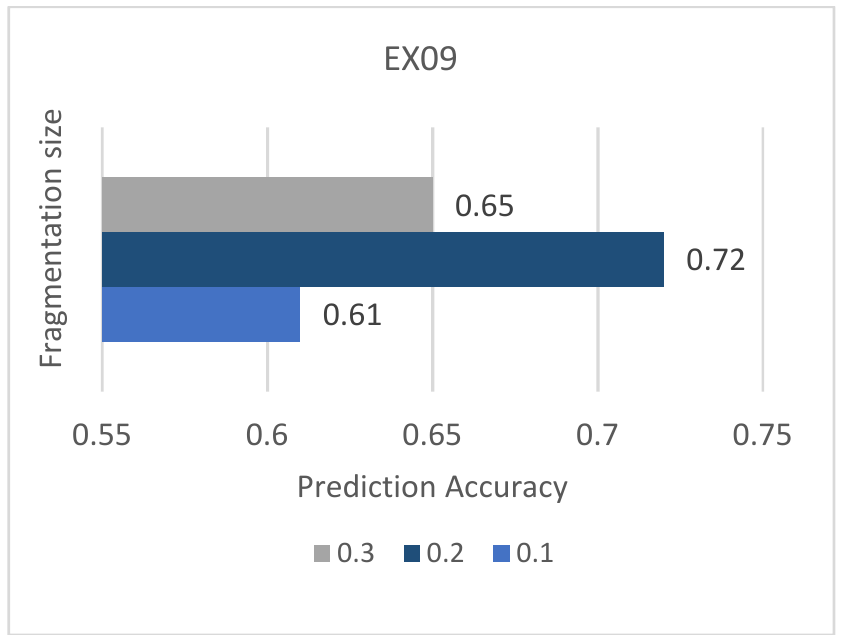
Figure 17. Obtained prediction accuracies of fragmenting Dataset_VI with fragmentation sizes of 0.1, 0.2, and 0.3 and applying Model_II with each resulting dataset (EX09).